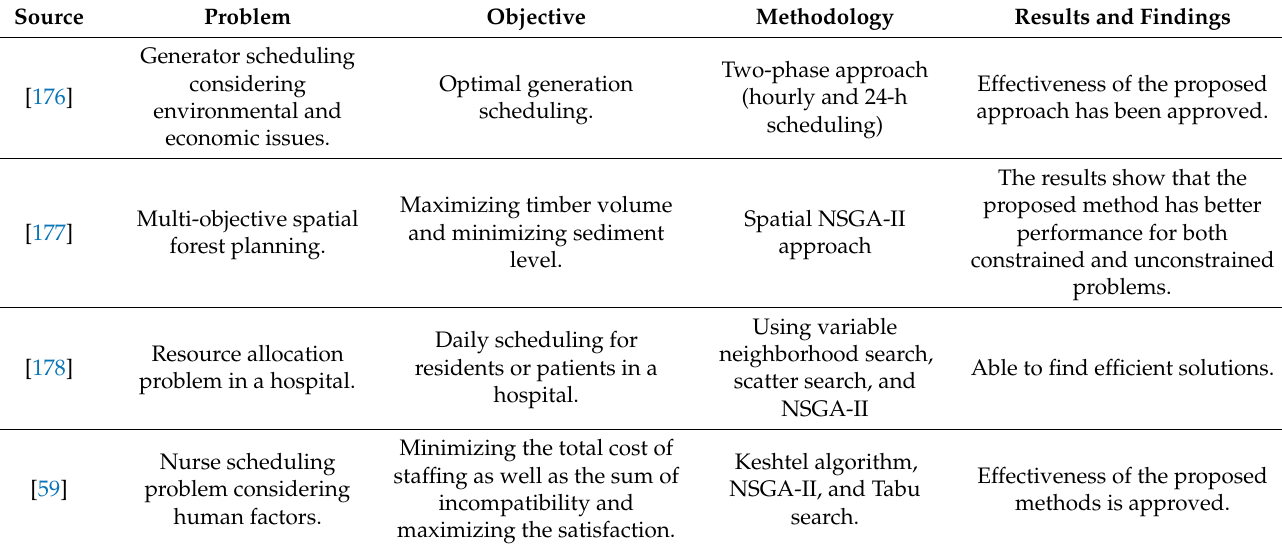
Table 6. Summary of the literature review on NSGA-II application in different fields, along with methodology and results.